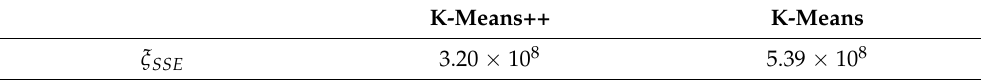
where m i is the centroid of the cluster c i . Table 3. The clustering performance of the K-means++ algorithm and K-means algorithm. K-Means++ As shown in Table 3, the SSE value of the K-means algorithm is smaller than that of the K-means algorithm. Hence, compared with the traditional K-means algorithm, the K-means++ algorithm adopted in this paper has better clustering